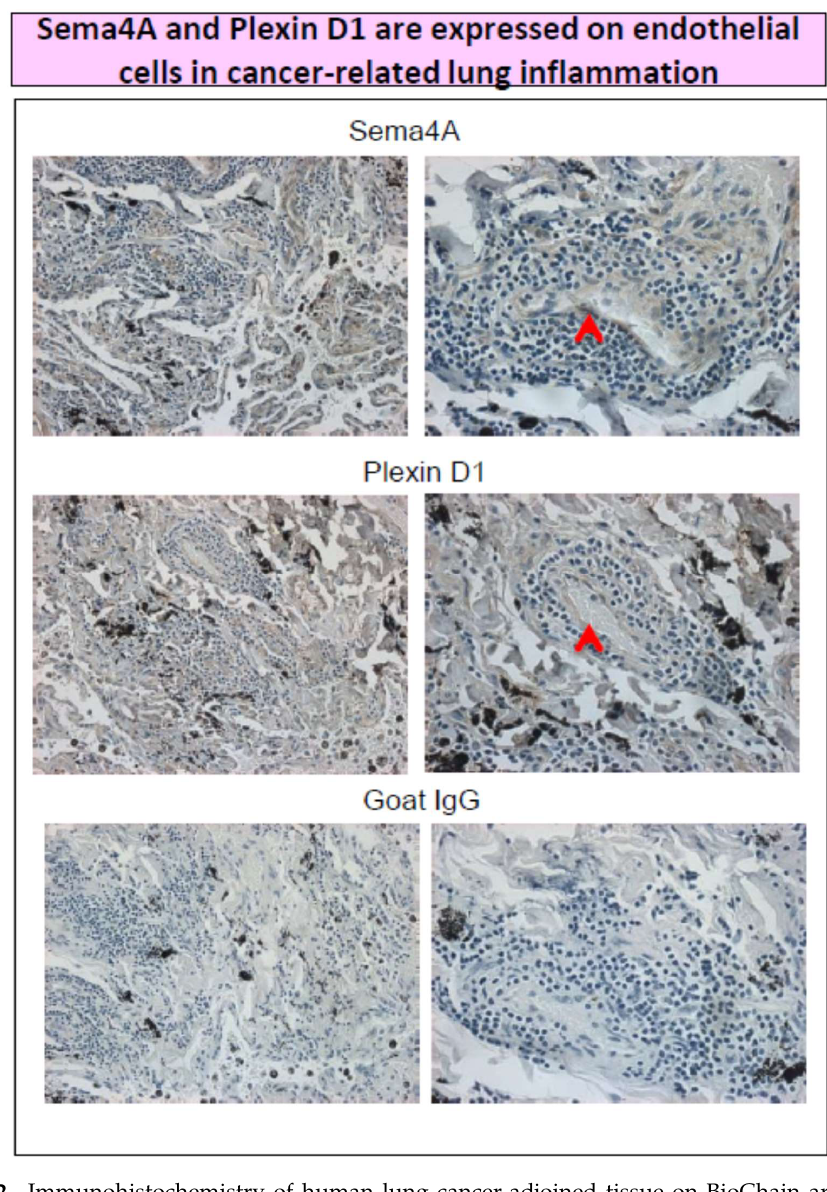
Figure 2. Immunohistochemistry of human lung cancer-adjoined tissue on BioChain arrays was performed as a four-step assay. Primary Ab for Sema4A (sc-46258) and Plexin D1 (E-13) were obtained from Santa Cruz Biotech. Streptavidin-HRP (Abcam) was used as a detection enzyme and